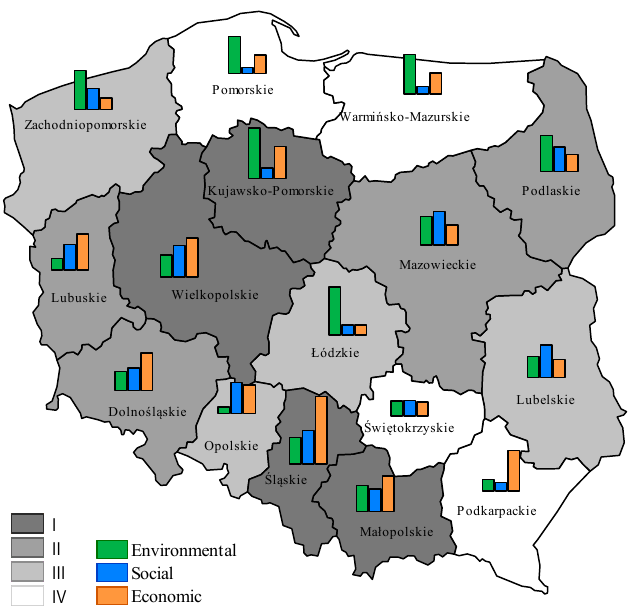
Figure 2. Diversification of sustainable transport development in particular voivodeships according to the order measure. Note: the background of the voivodeships—the integrated order (total measure), the height of the histogram—denotes the values of the synthetic measures for particular orders i.e., environmental, social, economic. Source: own